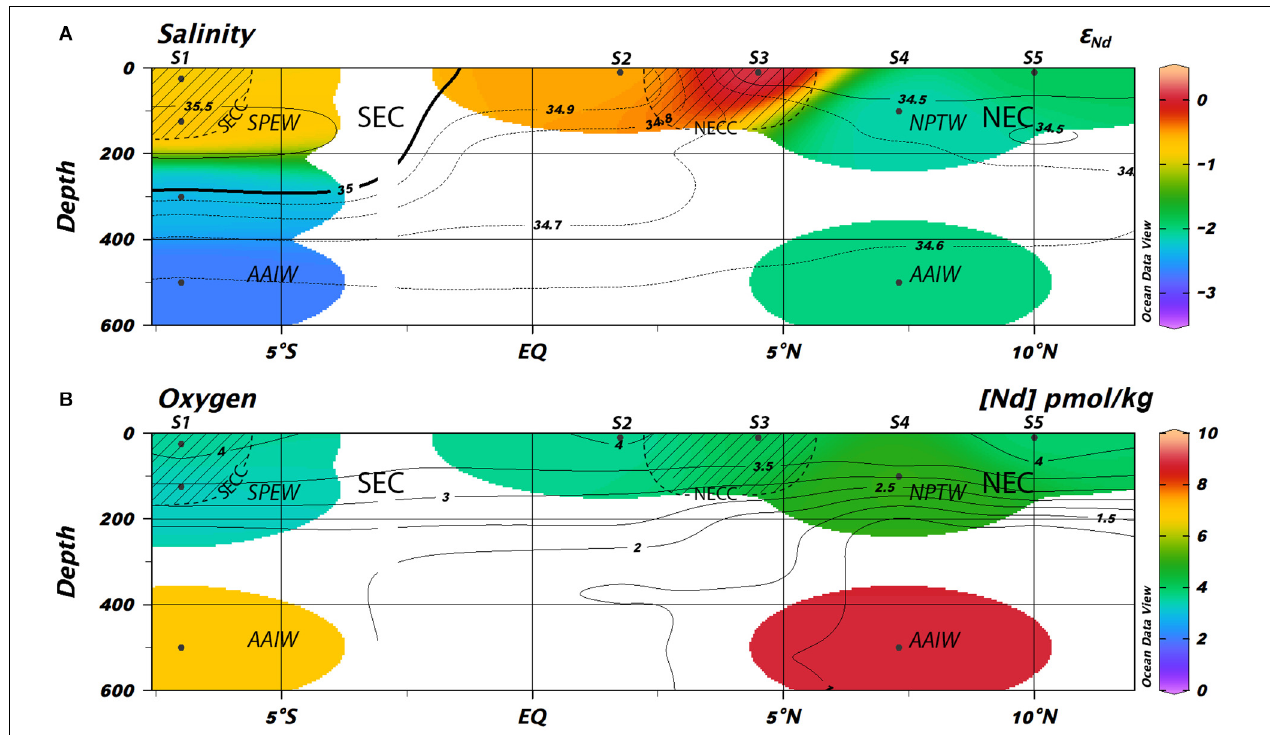
FIGURE 5 | Close-up of the ε Nd and [Nd] section between 7.5 ◦ S and 15 ◦ N and 0–600 m water depth with color-coded ε Nd and [Nd] values and salinity (A) and oxygen contours (B) . Approximate positions of water masses (italics) and major surface currents (bold) are marked. Shaded areas indicate eastward flow. Created using Ocean Data View (Schlitzer, 2020) and further